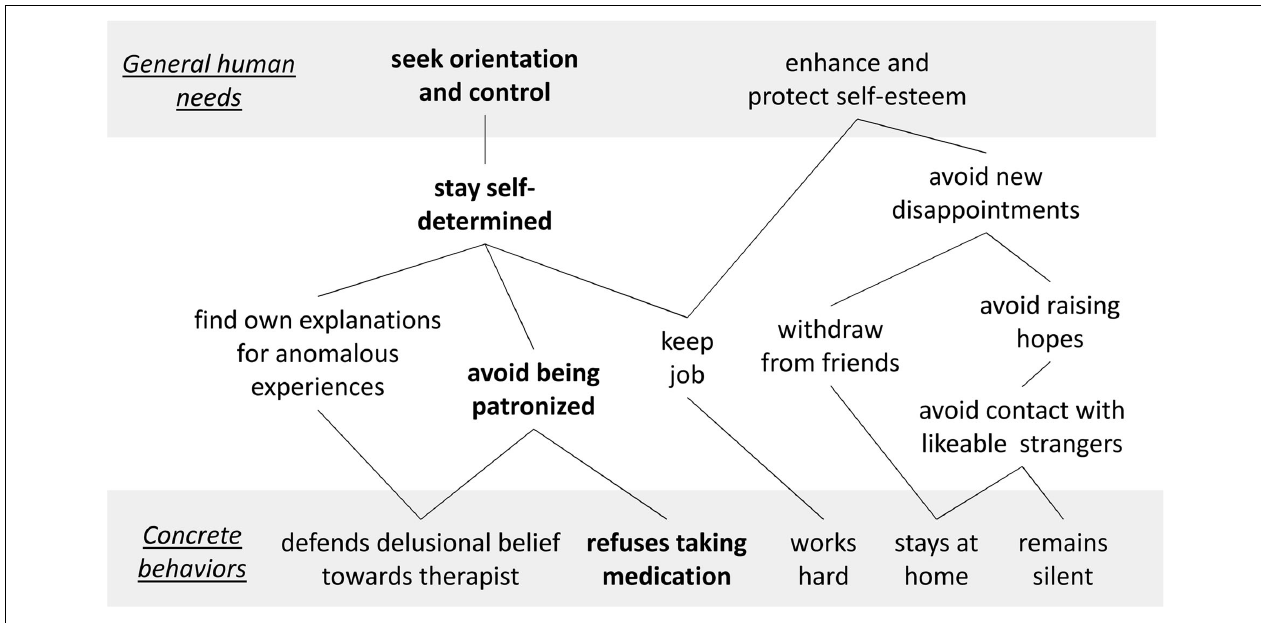
FIGURE 1 | A hypothetical Plan